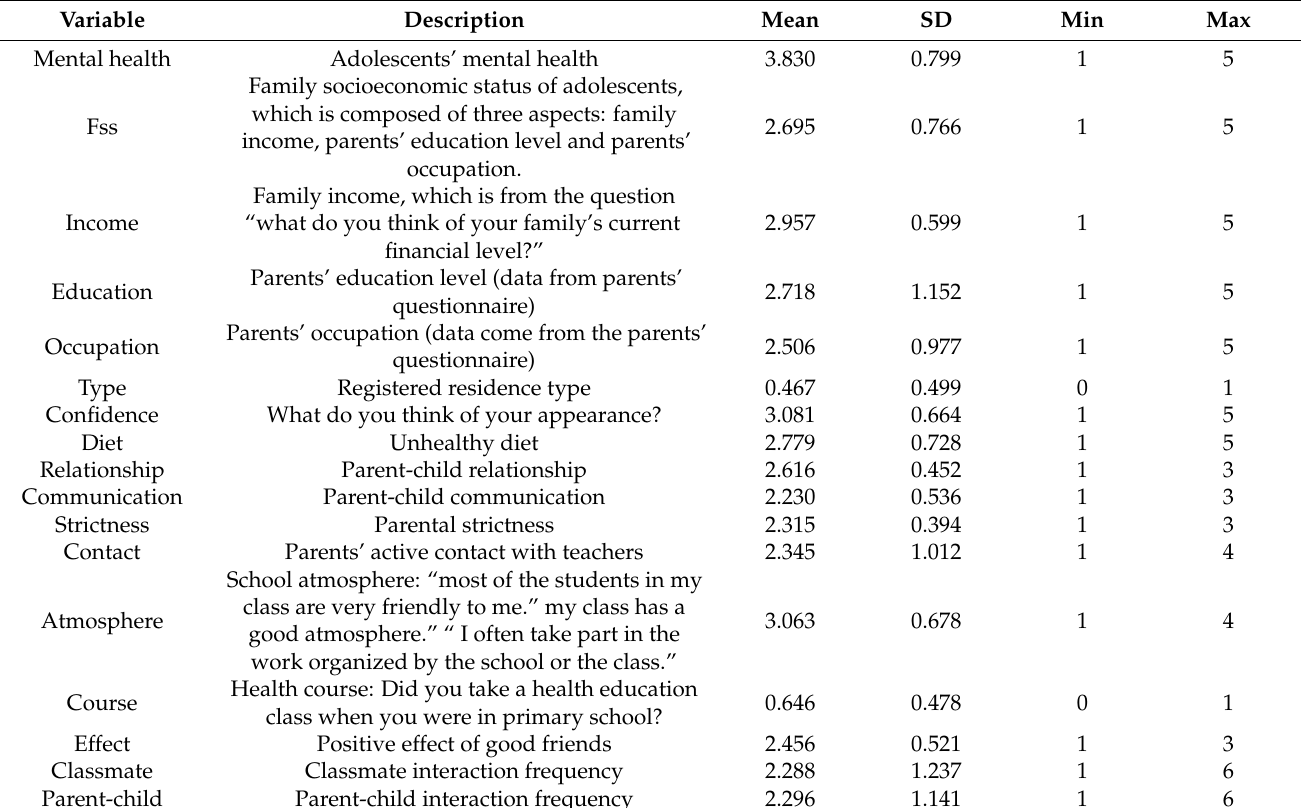
Table 2. Variables and descriptive